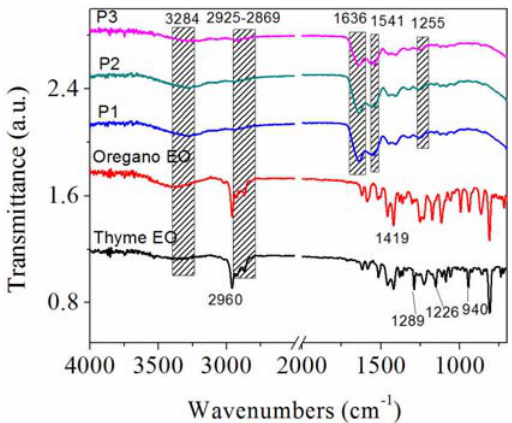
Figure 5. Normalized ATR-FTIR spectra for thyme essential oil, oregano essential oil, collagen nanofibres and collagen loaded with essential oils.